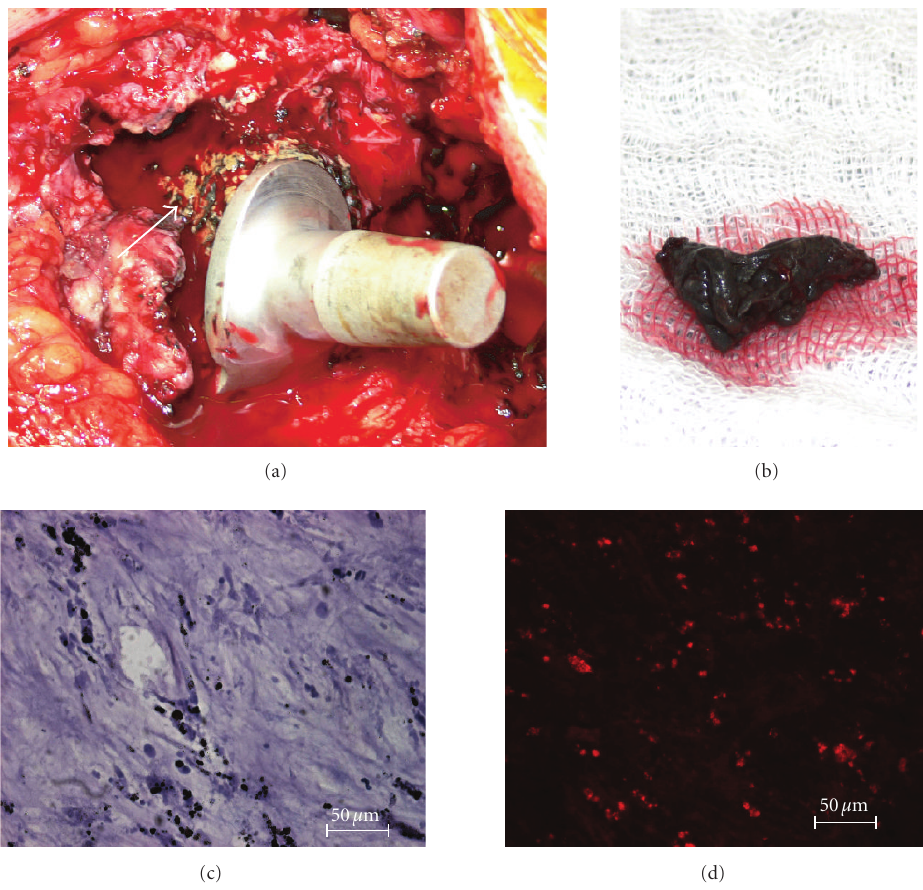
Figure 5: Although traditional biocompatibility focuses on the implant-host interface the movement of particles within the human body should be considered. As shown above micro- and nanoparticles derived from the acetabular component of a failed artificial total hip joint were transported by di ff usion and/or cell migration to the proximal femur and induce severe peri-implant osteolysis. (a) The bone around the proximal femur is resorbed (arrow) and substituted by layers of fibrous soft tissue. (b) The black colour of peri-implant tissue presented on a lab sponge results from metal wear debris (metallosis). (c) The tissue section of the fibrous layer showed small intra- and pericellular particles in di ff erent sizes (estimated size range 0.1–10 μ m) in H.E. staining. (d) The immunfluorescent CD68 staining showed the high number of activated macrophages (red) within the fibrous